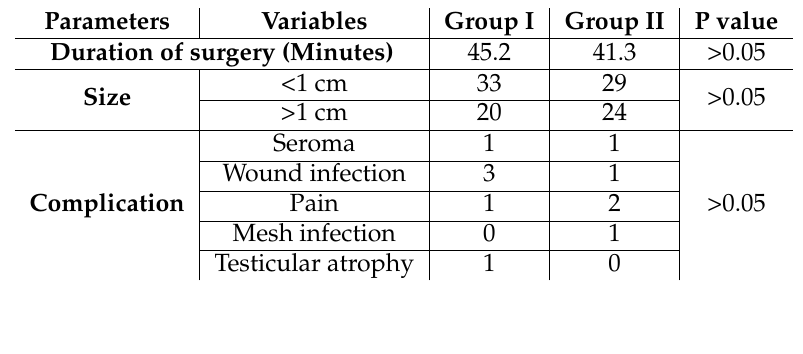
Table 2. Assessment of